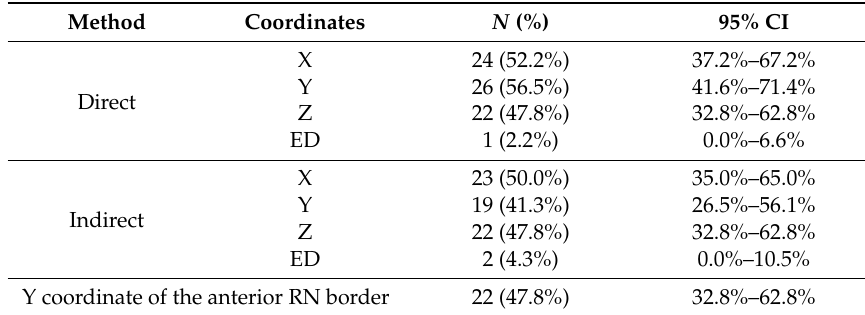
Table 2. Numbers and percentages of the coordinates of the direct, indirect and RN borders within ± 1.0 mm of the final Figure 12. The Y coordinates in relation to the MCP.